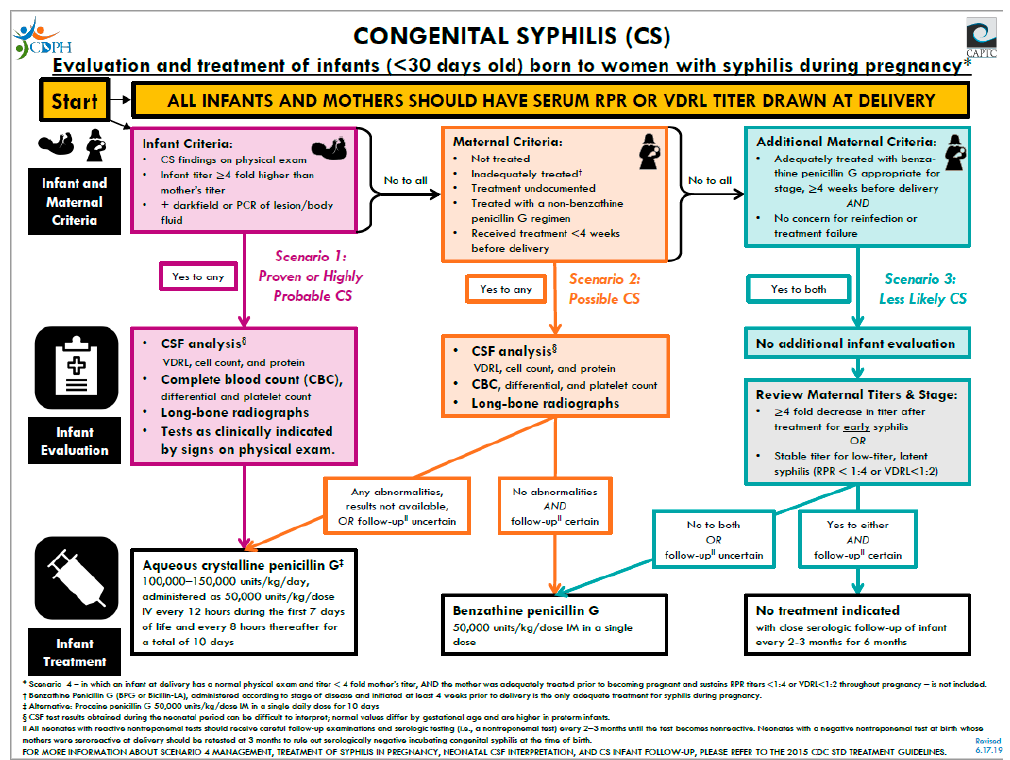
Figure 5. Algorithm for treatment of congenital syphilis. Figure produced by the California Department of Public Health [31].